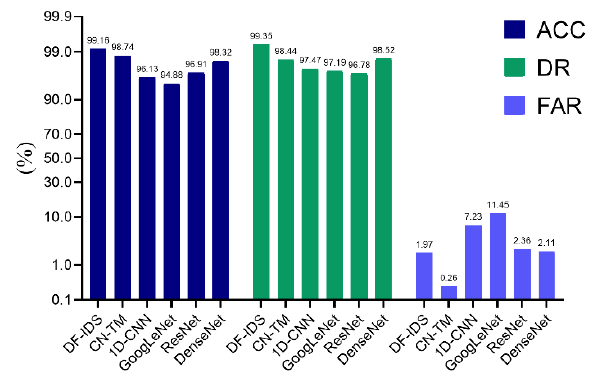
Figure 7. Comparison of binary classifications.